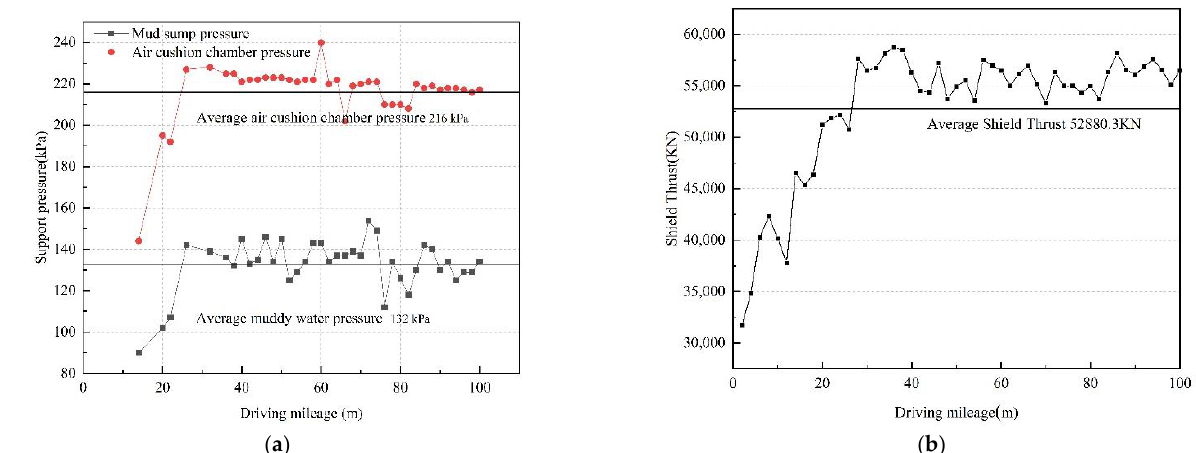
Figure 5. Tunnel construction and excavation parameters ( a ) support pressure, ( b ) shield thrust.